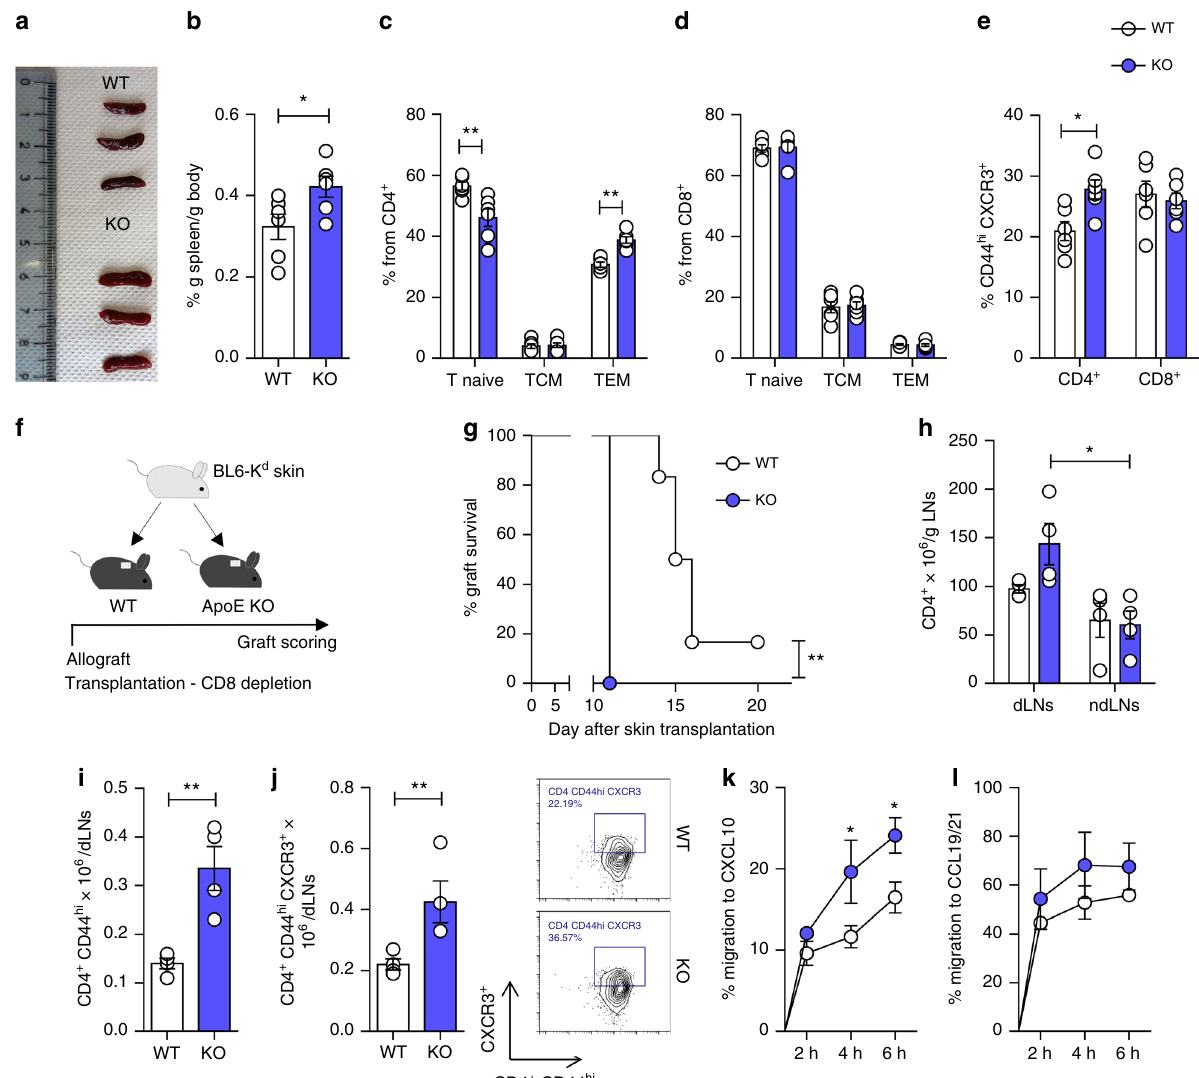
Fig. 1 ApoE de fi ciency promotes CD4 + T-cell activation and skin allograft rejection. a – b Representative images ( a ) and percentage of spleen weight corrected for body weight ( b ) from WT and apoE KO mice. c – d Frequency of CD4 + ( c ) and CD8 + ( d ) T-cells subsets in the spleen of WT and apoE KO mice. e Frequency of CD4 + and CD8 + activated CD44 hi CXCR3 + T cells in the spleen of WT and apoE KO mice. f Graphic representation of a typical skin allograft transplantation experiment: a piece of tail skin from C57BL/6K d donor was transplanted on the back of WT or apoE KO mice and graft survival was scored up to 3 weeks. g Graft survival following skin allotransplantation. Survival of less than 50% of the donor skin was recorded as rejection. h Number of CD4 + T cells in fi ltrating the lymph nodes (axillary and brachial) draining (dLNs) and (contra-lateral inguinal) non-draining (ndLNs) the graft, corrected for LNs weight. i – j Number of activated CD4 + T cells CD44 hi ( i ) and CD44 hi CXCR3 + ( j ) in the dLNs after allograft rejection; representative dot plots are shown. k – l Migratory response of T lymphocytes isolated from draining lymph nodes, after allograft rejection, to the chemokines CXCL10 ( k ) and CCL19/21 ( l ) measured by transwell. N = 4 ( g – l ) or 6 ( a – e ) per group. Statistical analysis was performed with unpaired T -test ( b , i , j ), Gehan-Breslow- Wilcoxon test ( g ) and two-way Anova ( c – e , h , k , l ). Data are reported as mean ± SEM; * p < 0.05, ** p < 0.01